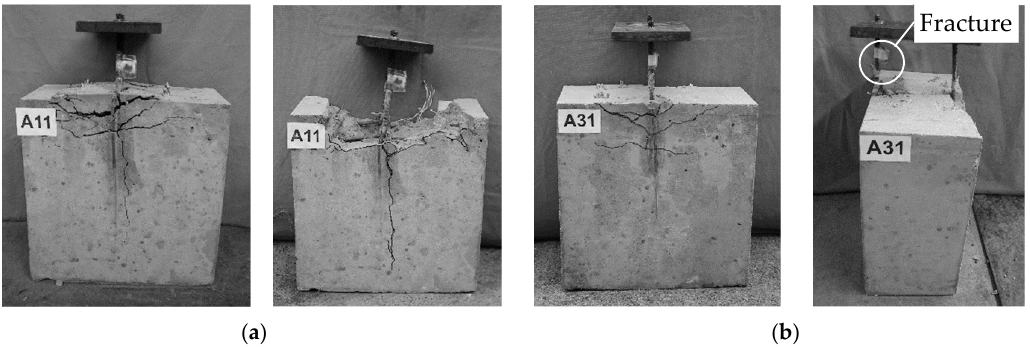
Figure 4. Cracks and failure patterns of specimens. ( a ) The crack and failure mode of A11; ( b ) The crack and failure mode of A31.